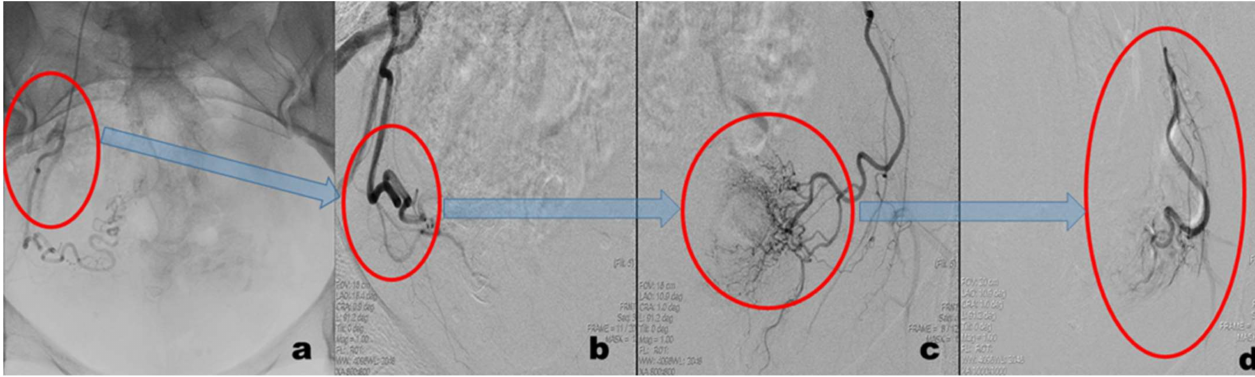
Figure 2. Embolization of the uterine arteries following a few simple steps, defined in the red circle: ( a ) introduction of a 5F Roberts catheter in the right femoral artery; ( b ) X-ray guidance of the catheter to the point of embolization; ( c ) release of polyvinyl alcohol or gelfoam particles to block the blood circulation in the placenta; and ( d ) blockage of the circulation system in the developing